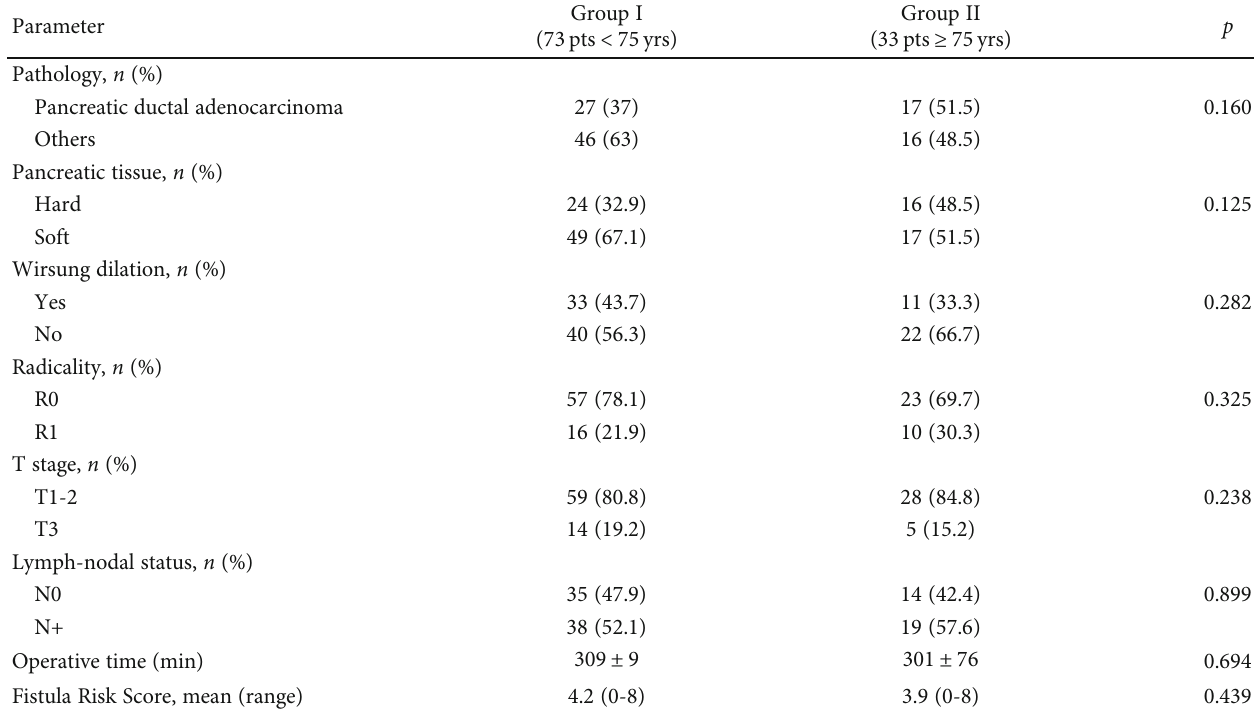
Table 2: Intraoperative and pathological data of 106